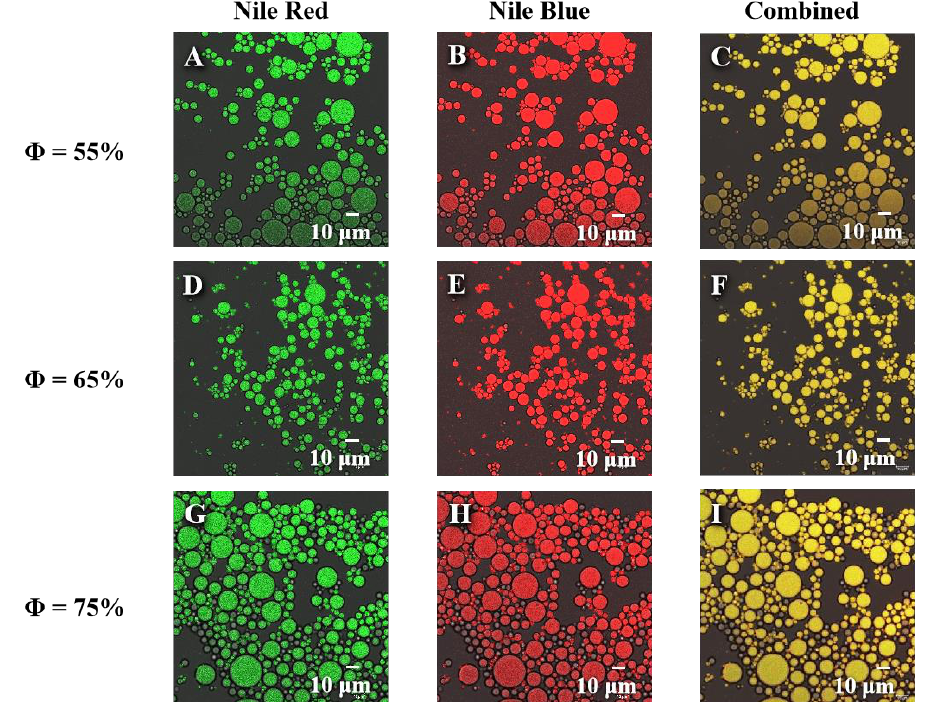
Figure 10. CLSM images of Pickering emulsions stabilized by Z3S1 with different oil fractions.